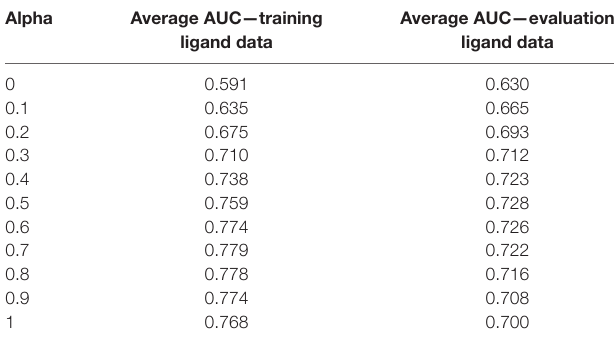
TaBle 1 | Performance improvement with combined prediction approach in terms of area under the ROC curve